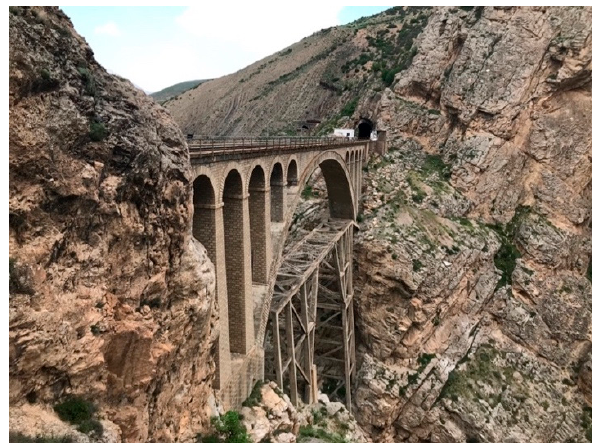
Figure 1. Veresk bridge, Northern Iran.